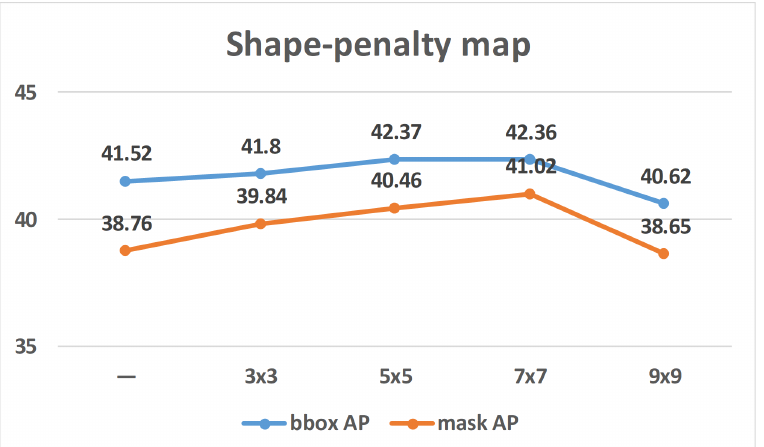
Figure 10. Effects of the shape-penalty map generated using different kernel sizes. “–” indicates the results of Mask R-CNN without using the shape-penalty